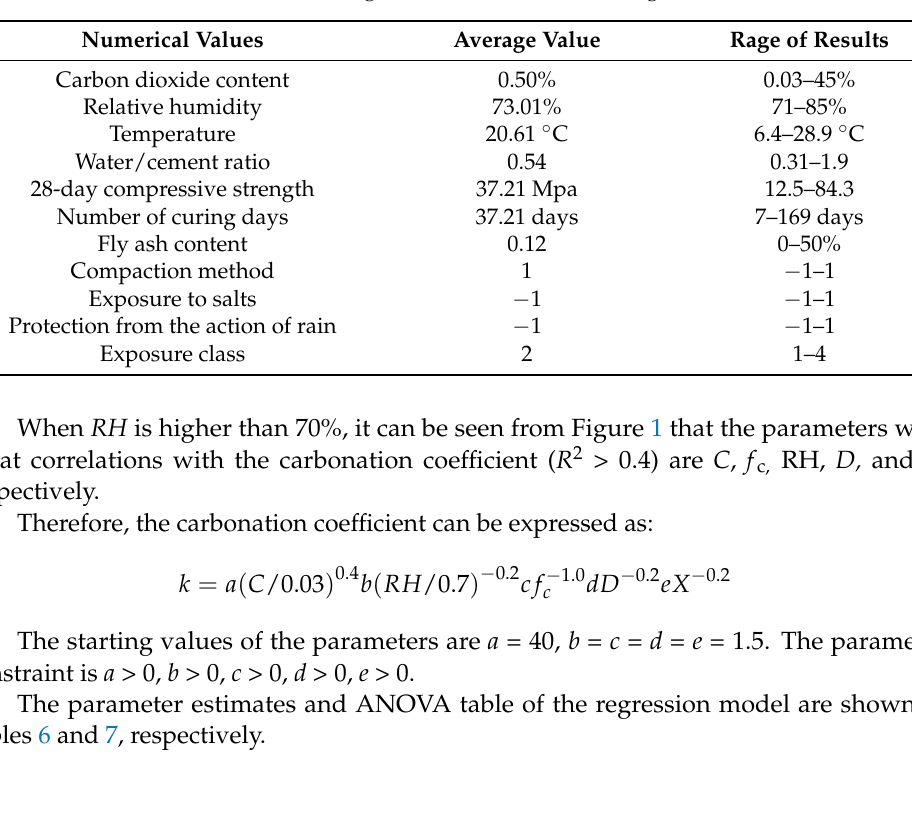
Table 5. Parameter estimates with RH higher than 70% after removing the